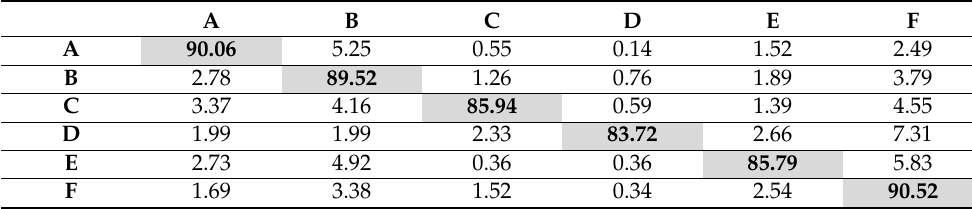
Table 5. Confusion matrix (%) of 2D ‐ DIDGP on Set 1 using Random Forest classifier.